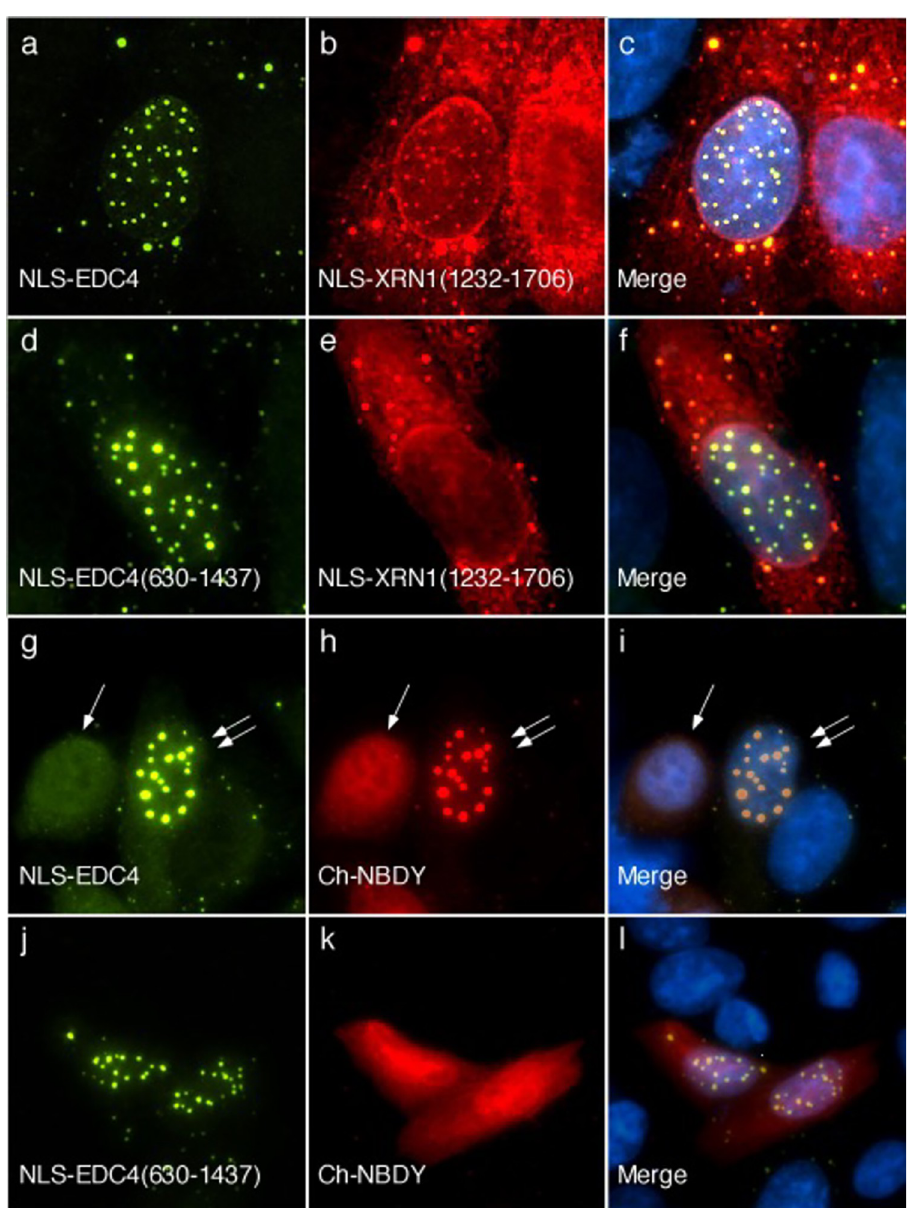
Fig 4. EDC4 interacts with XRN1. Transfection of HEp-2 cells with GFP-NLS-EDC4 (panel a) and monomeric cherry (mCh) fused to SV40 T antigen NLS and XRN1 amino acids 1232–1706 (mCh-NLS-XRN1(1232–1706) (panel b) resulted in localization of both proteins in nuclear dots (panel c) in 94+/-2% of cells expressing both proteins. Co- expression of GFP-NLS-EDC4(630–1437) and mCh-NLS-XRN1(1232–1706) resulted in localization of GFP-NLS-EDC4(630–1437) to nuclear dots (panel d) while mCh-NLS-XRN1(1232–1706) remained in cytoplasmic dots (panels e, f) in all cells that expressed both proteins. EDC4 interacts with NBDY. Co-expression of NLS-EDC4 (panel g) and mCh-NBDY (panels h, i) resulted in both proteins localizing diffusely throughout the nucleus in 59 +/-2% of cells expressing both proteins. In the remaining cells that expressed both proteins, mCh-NBDY co-localized with NLS-EDC4 in nuclear dots. A single white arrow in g-i indicates a cell expressing both NLS-EDC4 and mCh- NBDY with both proteins in a homogeneous nuclear staining pattern. Double white arrows in g-i indicate a cell with both proteins in nuclear dots. Localization of GFP-NLS-EDC4(630–1437) to nuclear dots (panel j) was not affected by expression of mCh-NBDY (panels k, l). Human serum was used to detect NLS-EDC4 in panels a and g, and mouse monoclonal anti-GFP detected GFP-EDC4(630–1437) in d and j. Rabbit anti-mCh antiserum was used to detect mCh- NLS-XRN1(1232–1706) in b and e and mCh-NBDY in h and k. Merge of panels a and b, d and e, g and h, and j and k is shown in c, f, I and l respectively. DAPI staining (blue) indicates the location of nuclei in c, f, i and l.